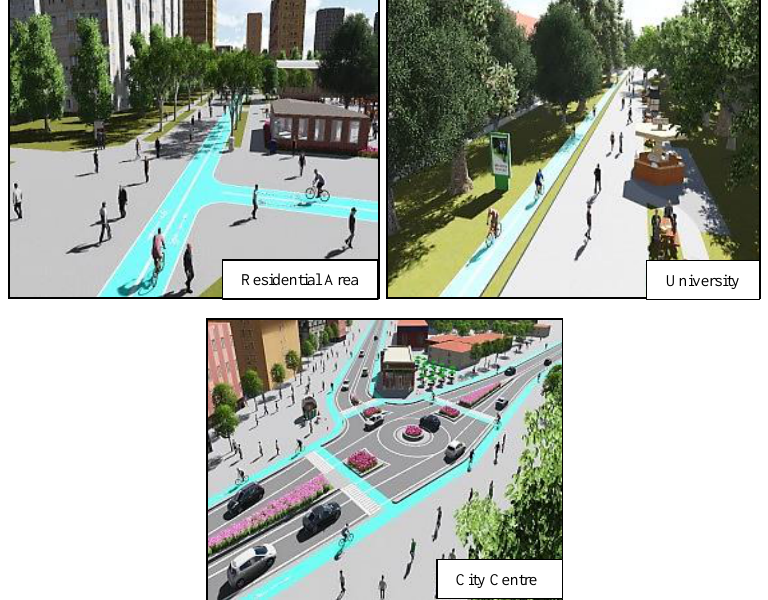
Figure 4. The Turkish locations as they might look in Shift Vision.